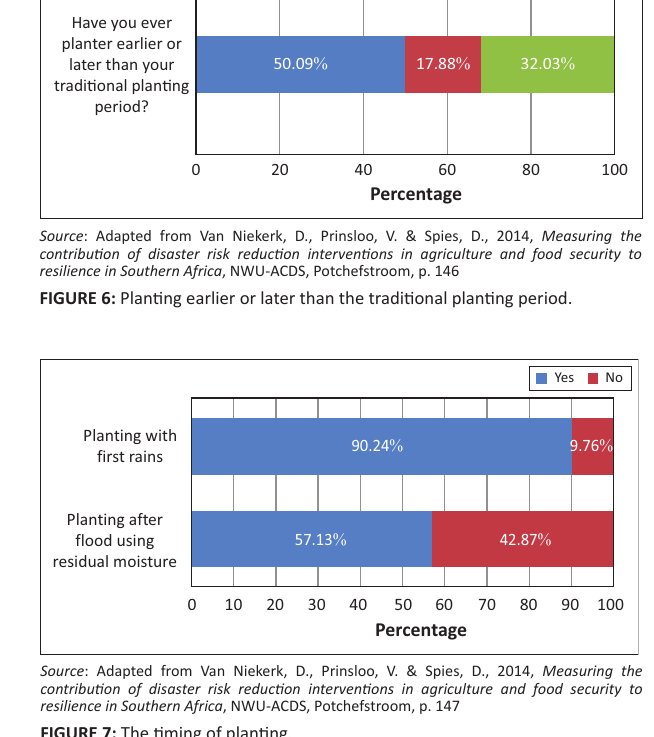
FIGURE 5: Factors determining planting time.